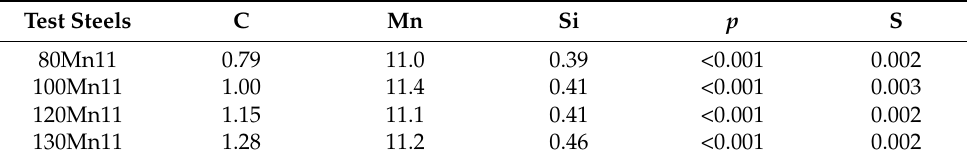
Table 1. Chemical compositions of high manganese austenitic steels (wt.%). Test